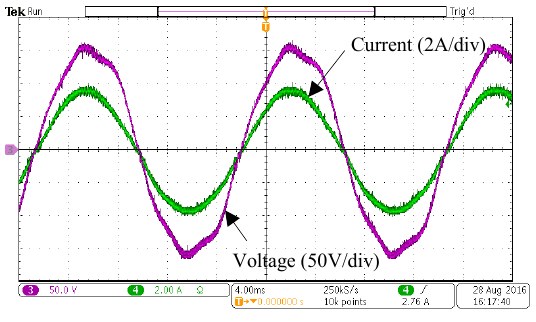
Fig. 19. Output voltage and output current when L g = 19.5 mH ( k p = 2)